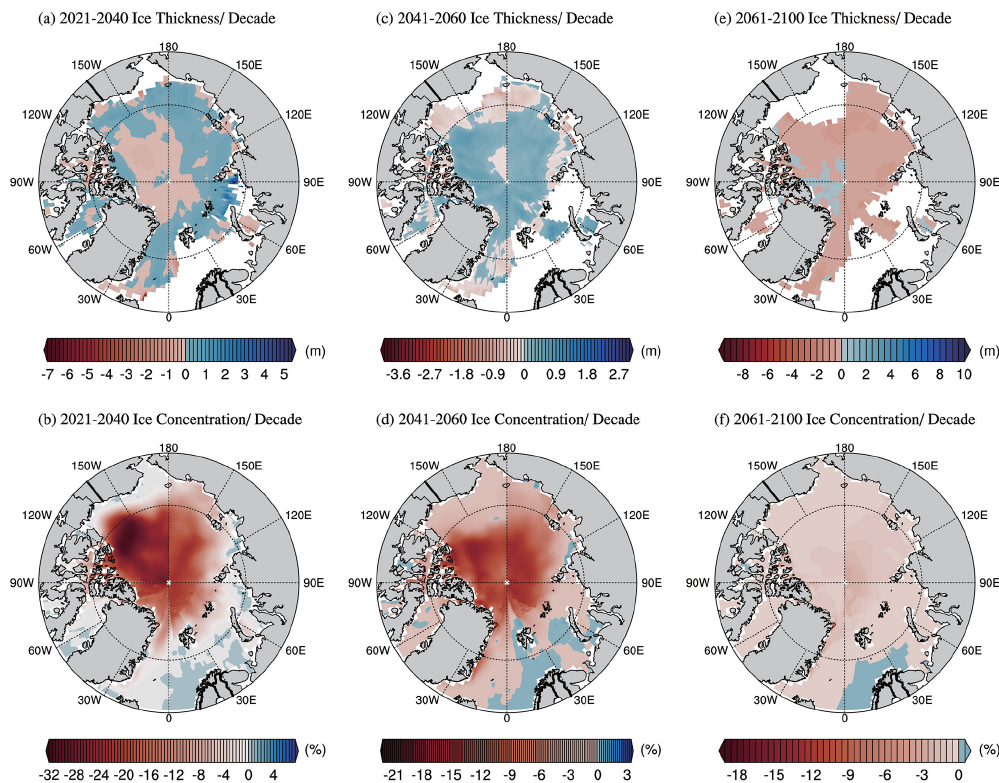
Figure 4. Linear trends of sea ice thickness and concentration under SSP5-85 in September.